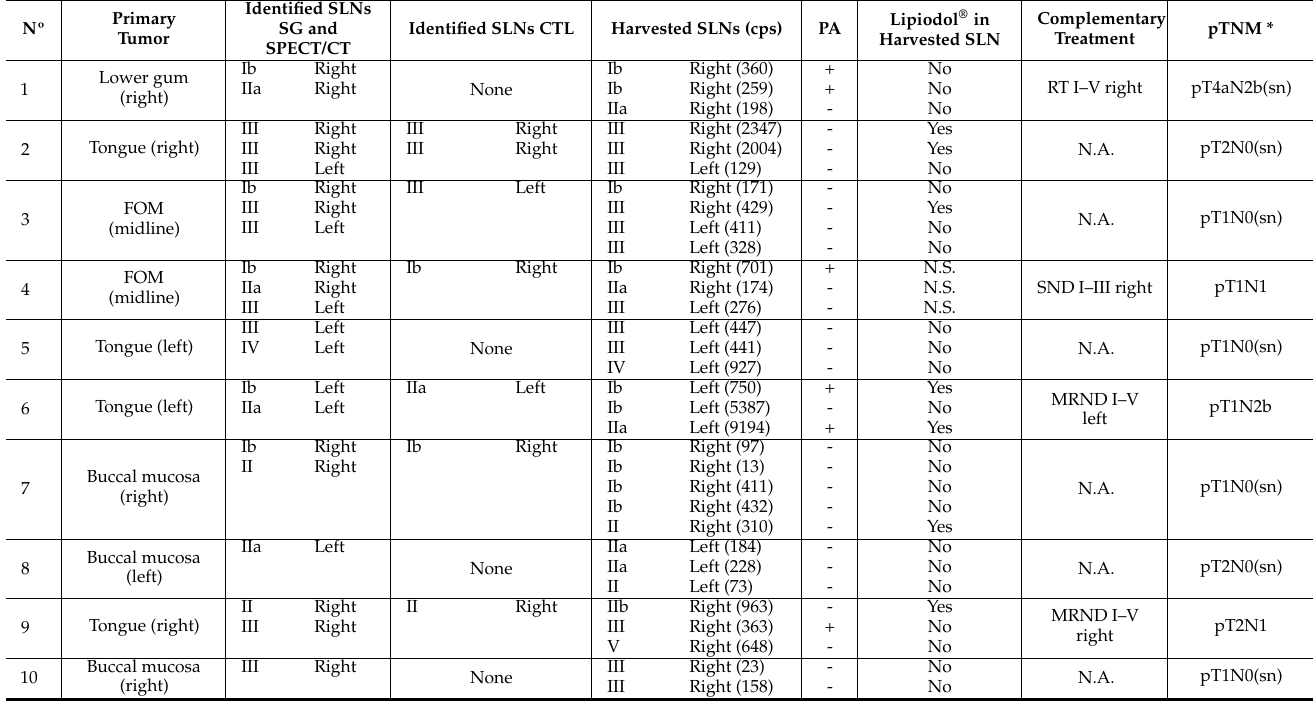
Table 2. Comparison of sentinel lymph node distribution between CT lymphography and 99m Tc- nanocolloid lymphoscintigraphy.